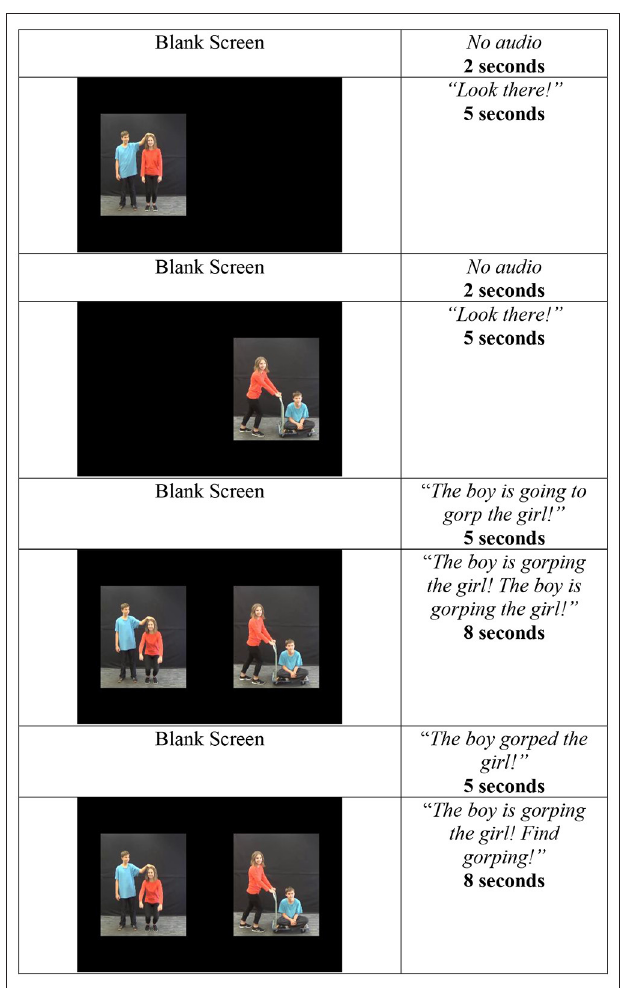
FIGURE 2 | Structure of the Intermodal Preferential Looking (IMPL) task with novel verbs.